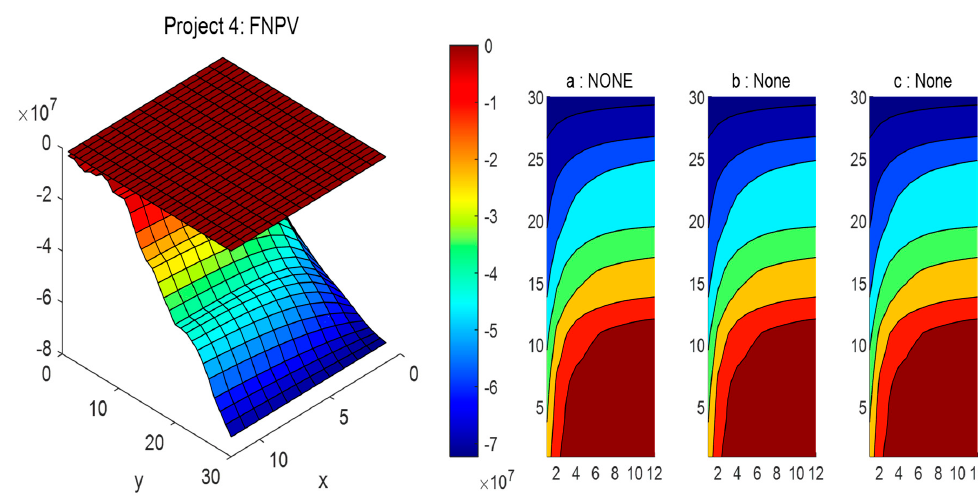
Figure A6. Decision-making for project 3. Figure A6. Decision − making for project 3. Figure A6. Decision − making for project 3.